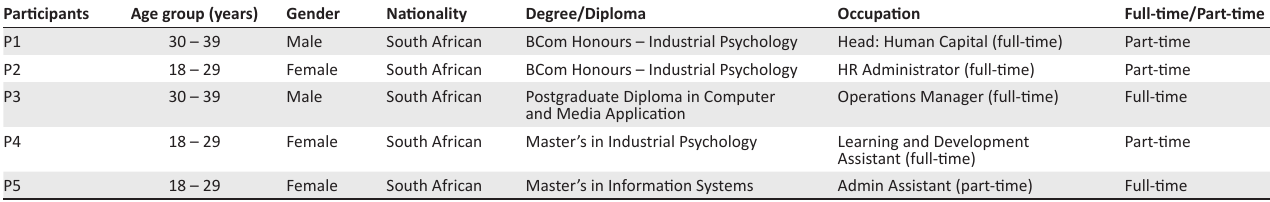
TABLE 1: Biographical information of participants.